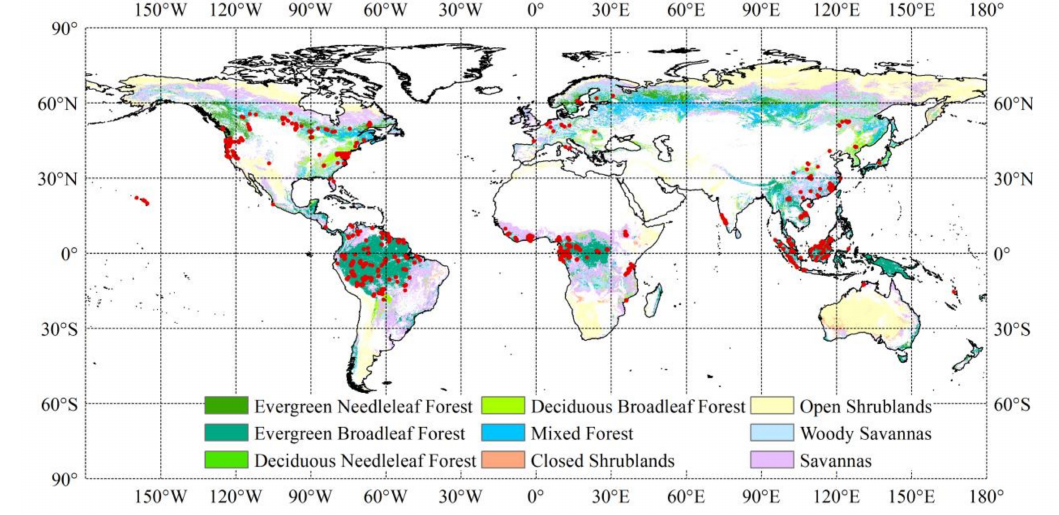
Figure 1. The spatial distribution of reference aboveground biomass (AGB) data. The background map shows the forest types according to the International Geosphere-Biosphere Programme classification based on MCD12Q1 data for